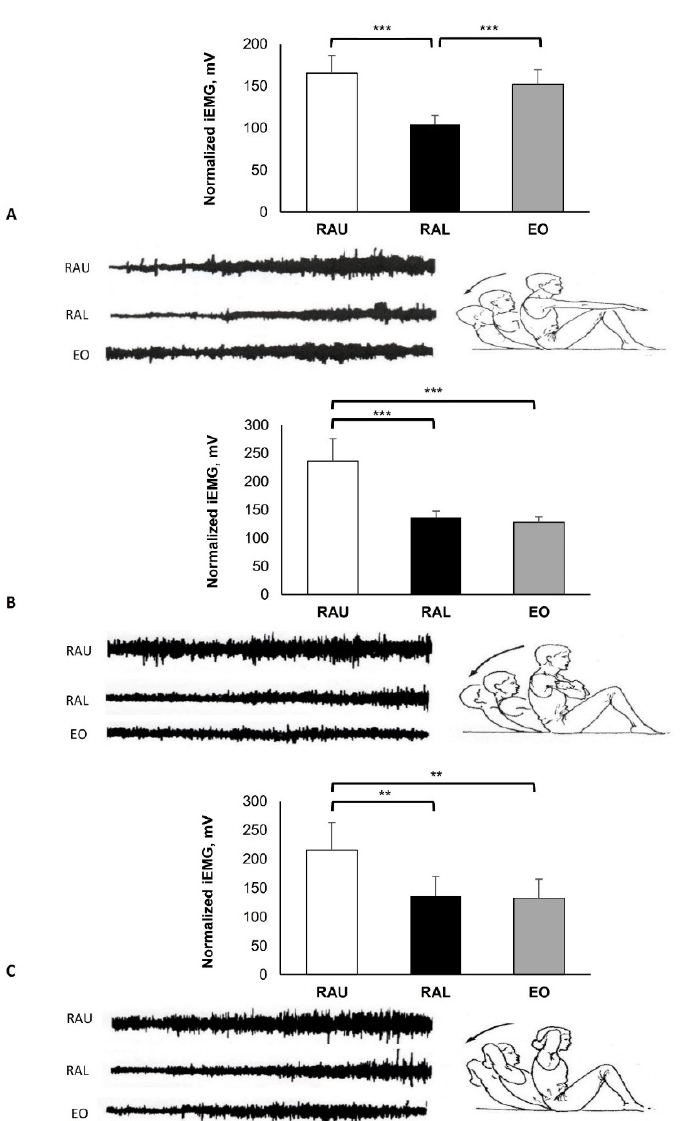
Figure 8. Eccentric exercises. From full trunk flexion with unsupported knees, and hands directed ( A ) forward, ( B ) on the chest, and ( C ) behind the neck. Slow trunk extension with rounded back on the floor. Group mean electric activity during the exercise. iEMG indicates surface electric activity. Raw EMG activity of the three muscles from one participant. RAU = rectus abdominis upper part; RAL = rectus abdominis lower part; EO = external oblique. Difference between muscles: ** p < 0.01; *** p < 0.001.